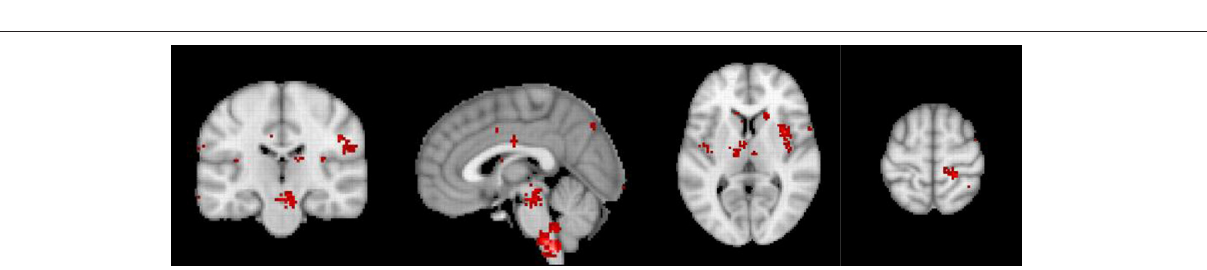
(SSC) encodes the discriminatory/sensory components of